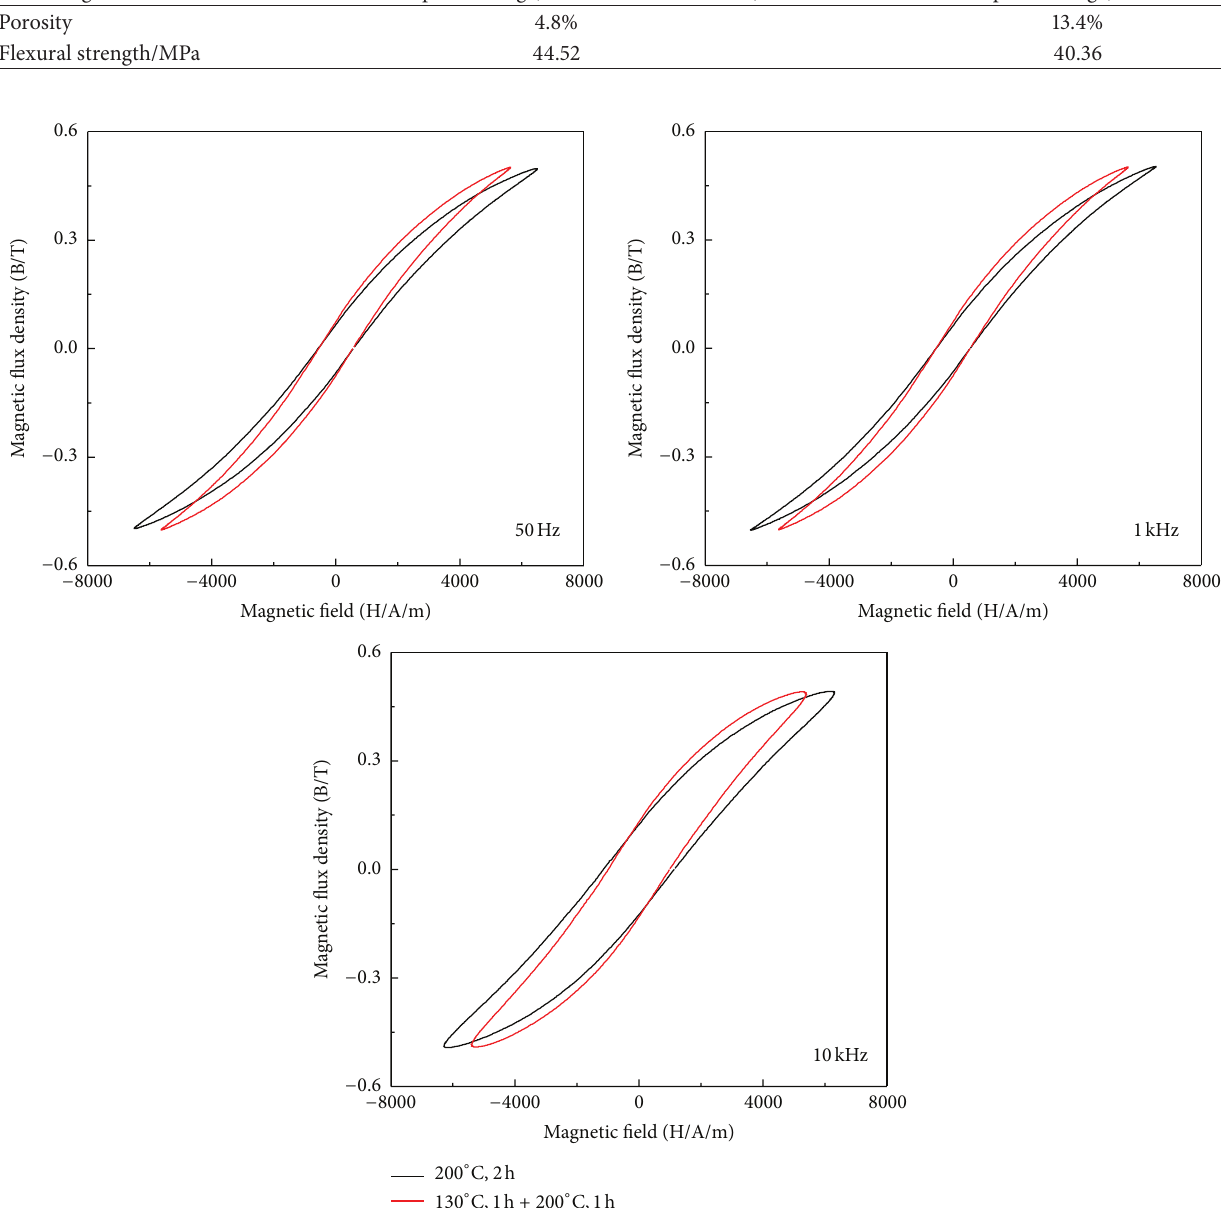
Figure 7: Magnetic hysteresis loops of SMCs at different